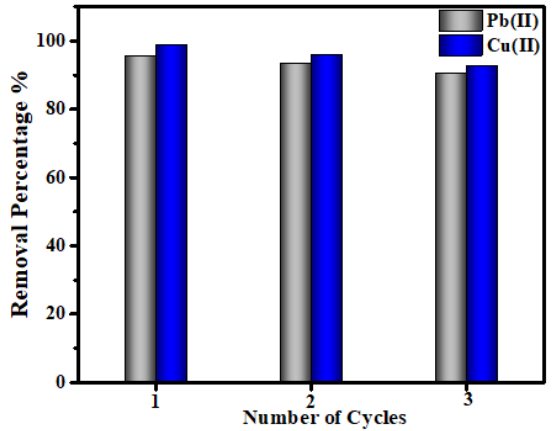
Figure 9. MgO nanorods recyclability.